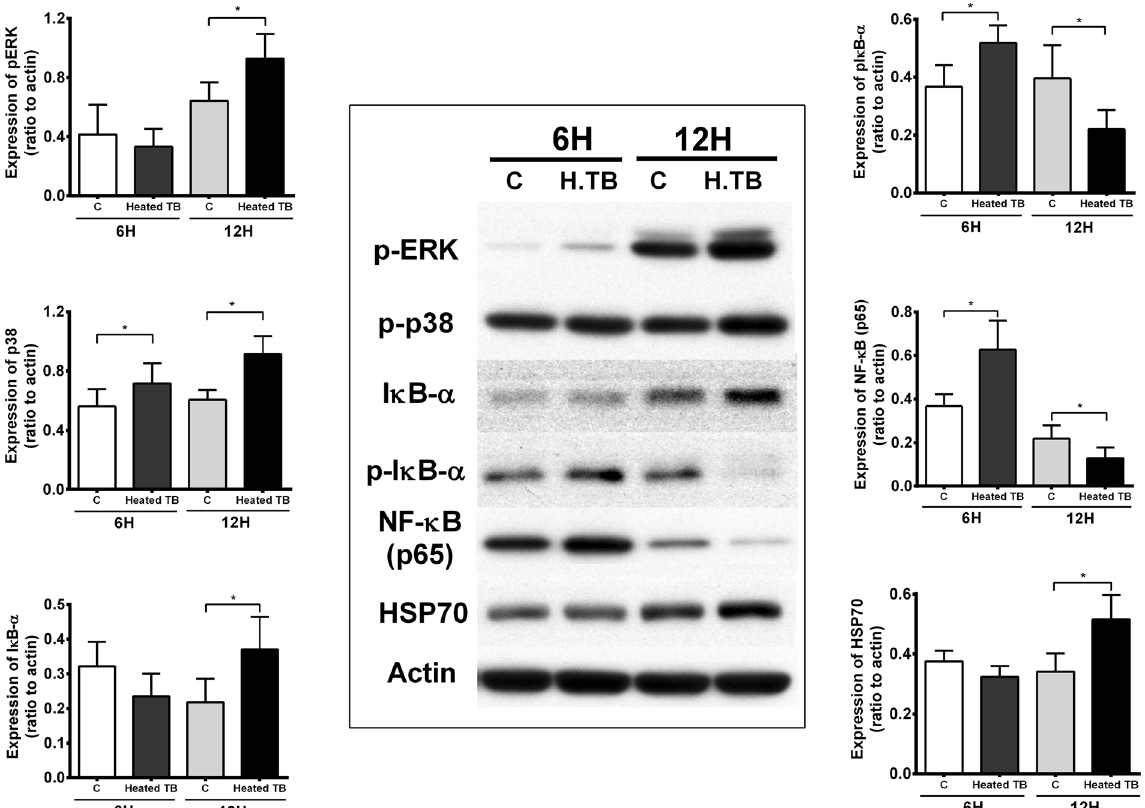
Figure 4. Western blot analysis to quantify the expression of MAPK (p38 and ERK), I κ B- α , NF- κ B p65 and HSP70 in alveolar macrophages of normal subjects (n = 6) after incubation with heated TB bacilli for 6 and 12 hours. * p < 0.05 compared with control.